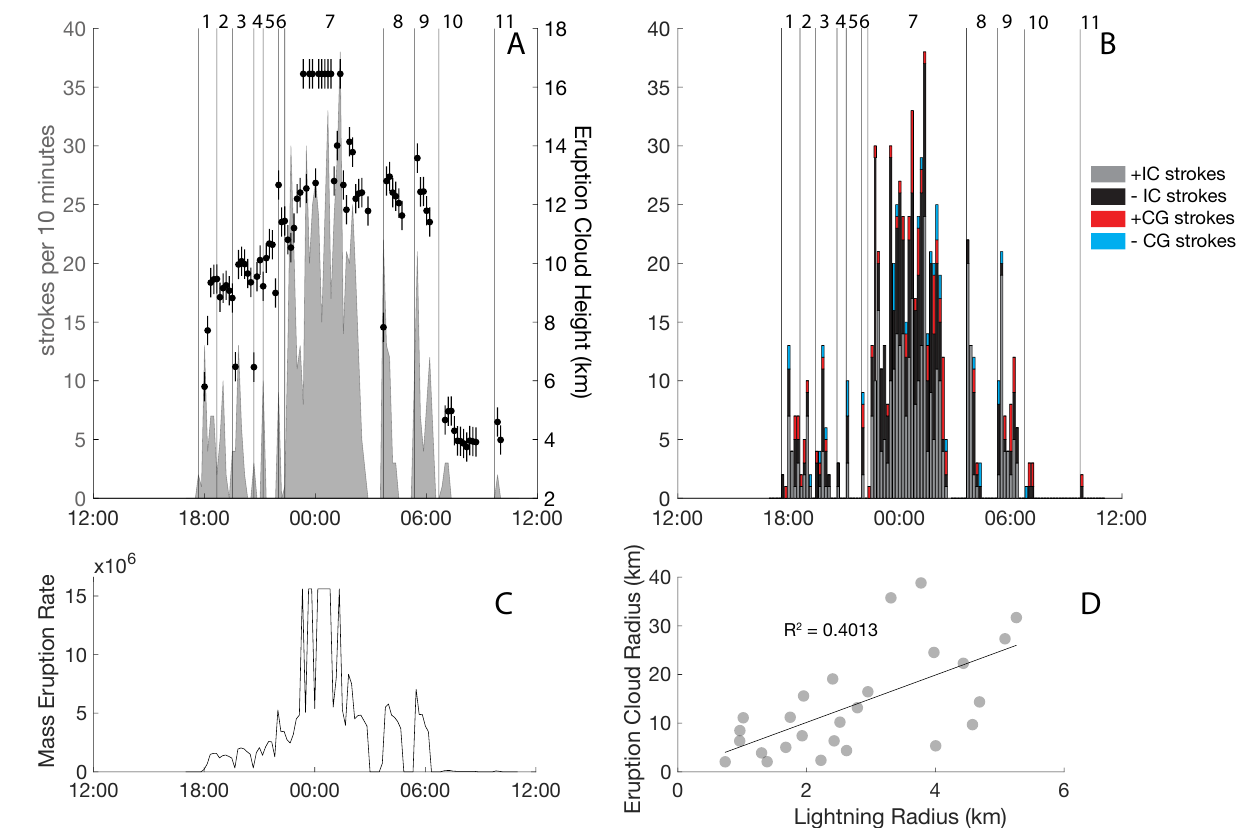
Figure 3: Timeline of Raikoke’s volcanic lightning and plume activity from 21–22 June 2019. [A] Lightning stroke rates per 10 minutes (gray, left axis) and maximum plume heights (black dots, right axis); vertical lines delineate the individual eruptive pulses examined in this analysis; [B] lightning stroke rates detailing proportions of positive, negative, in-cloud (IC) and cloud-to-ground (CG) strokes; [C] mass eruption rates (in kg s − 1 ) as calculated from plume heights using an empirical plume height scaling equation; [D] relationship between the size of the lightning footprint (‘lightning radius’ derived from the area where lightning occurred) and the size of the eruption cloud, shown as area-equivalent circular radius. Note: the x-axes of [A–C] give time (hh:mm) in UTC beginning on 21 June